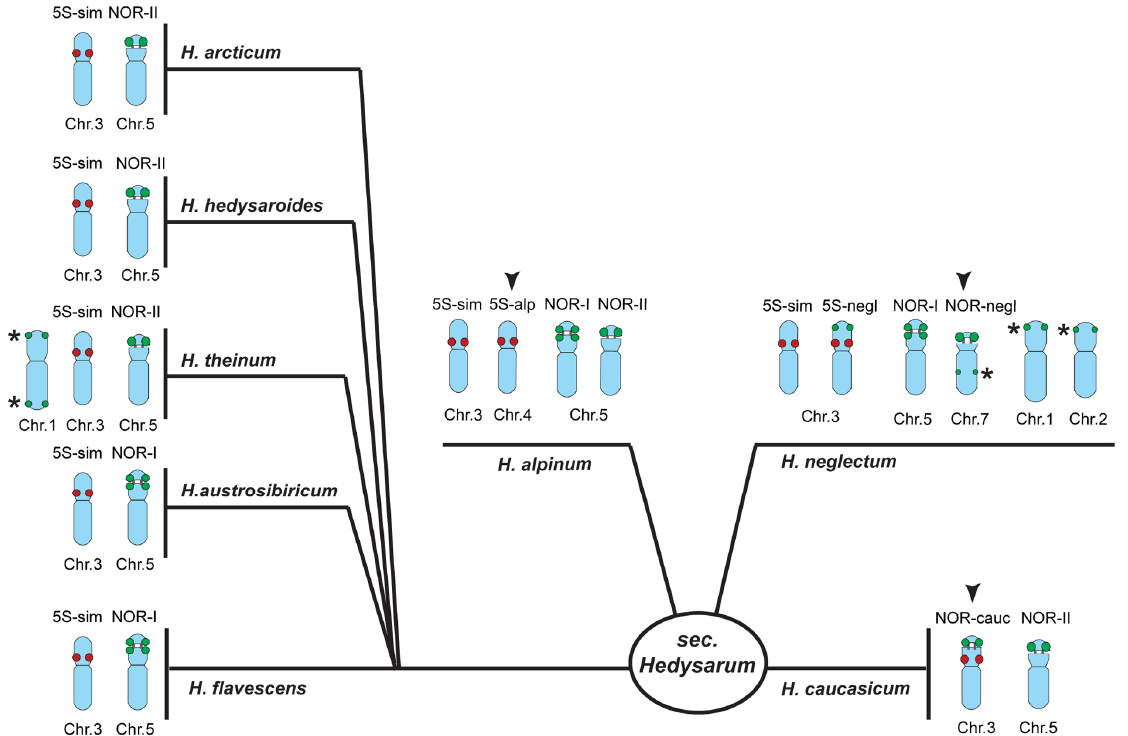
Figure 6. Four main groups of karyotypes within the sect. Hedysarum based on chromosome localization of 45S rDNA and 5S rDNA clusters. Heads of arrows indicate the revealed species-specific chromosome markers. Asterisks denote polymorphic minor 45S rDNA